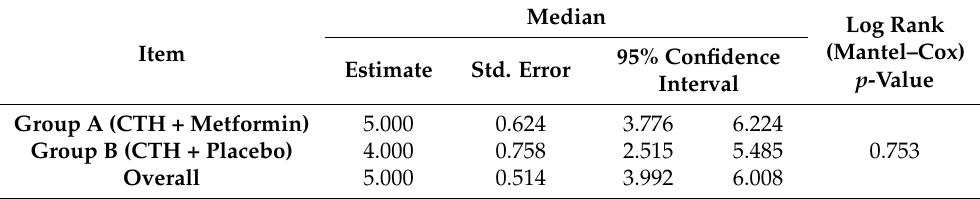
Table 7. PFS among both studied groups (n =